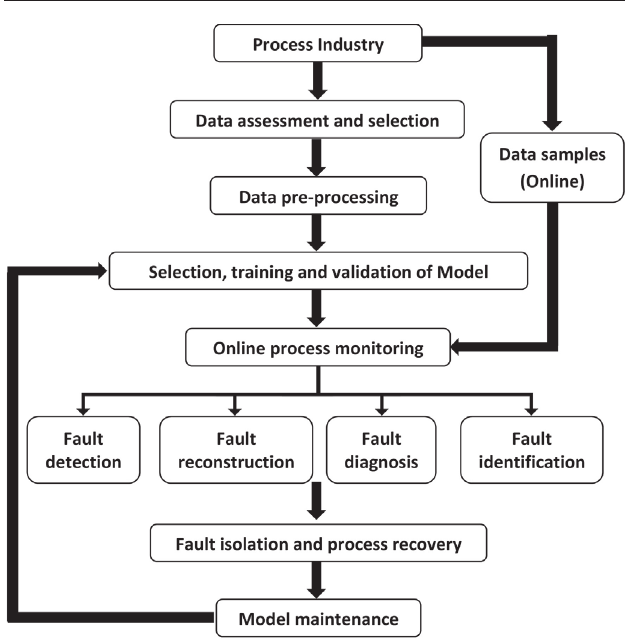
Fig. 1 – Data-based process monitoring